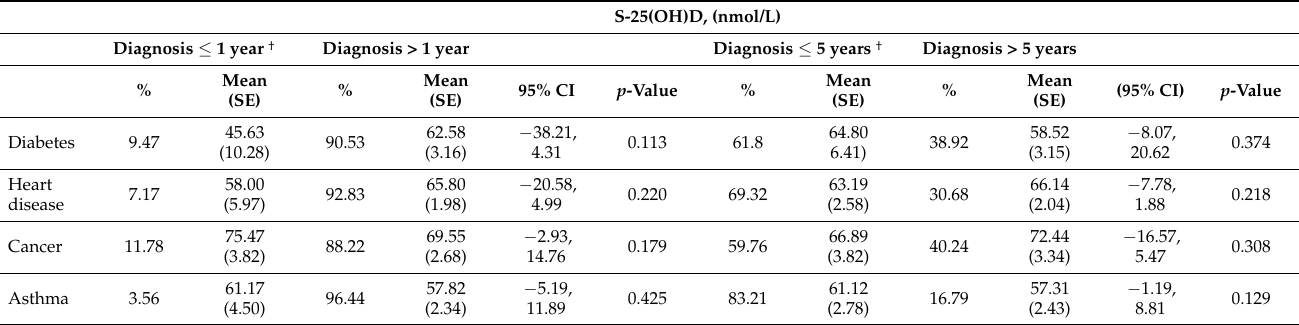
Table A4. Weighted mean 25(OH)D for each chronic disease based on the date of diagnosis: recent (e.g., ≤ 1 year) versus long-term (e.g., >1 year).